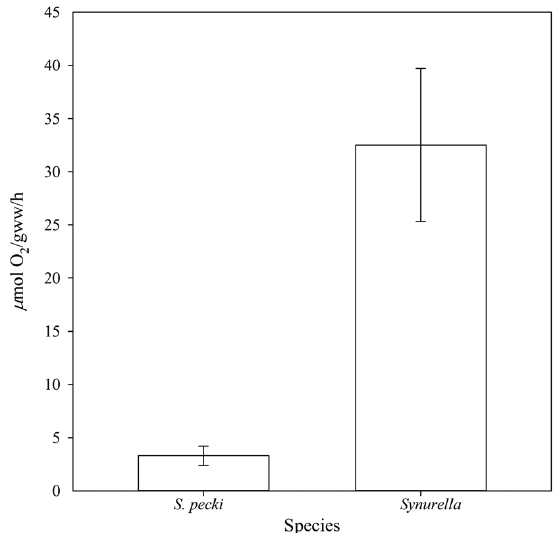
Figure 1. Oxygen consumption in darkness for Stygobromus pecki and Synurella at 23 °C. Values are means ± Standard Error Means (SEM) for n = 5